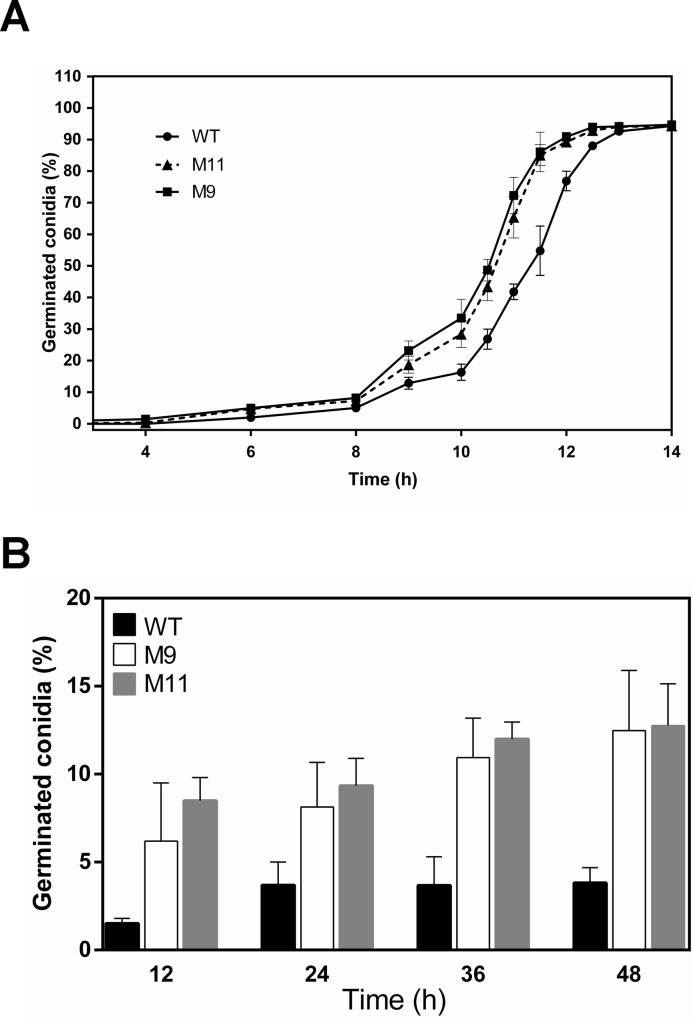
Germination rates of P. roqueforti CECT 2905 (WT) and transformants M9 and M11.(A) Germination kinetics in CM rich medium, represented as the percentage of germinated conidia vs. hours of incubation. Error bars represent the standard deviation of three replicates in three independent experiments. When the same experiment was performed in Czapek minimal medium, the same behavior was observed (not shown). (B) Germination in Czapek minimal medium lacking a carbon source. Percentage of germinated conidia after 12, 24, 36 and 48 hours of incubation is plotted. Error bars represent the standard deviation of three replicates in three independent experiments. Both in (A) and (B), no differences were observed between the wild-type strain and P. roqueforti containing empty pJL43-RNAi vector (not shown).